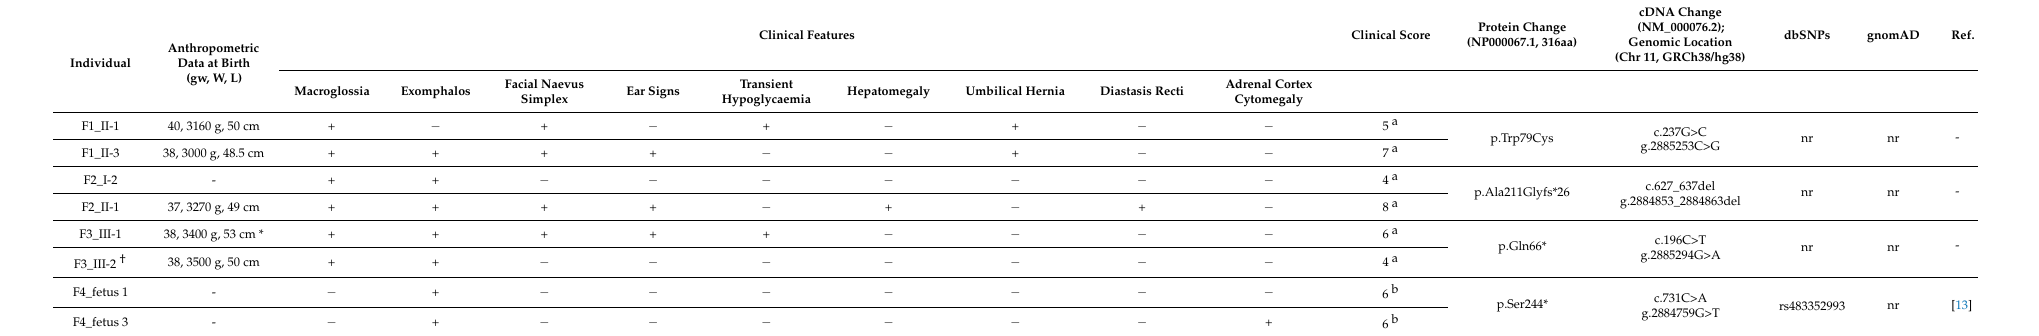
Table 1. Beckwith-Wiedemann syndrome cases and CDKN1C pathogenic variants identified in this